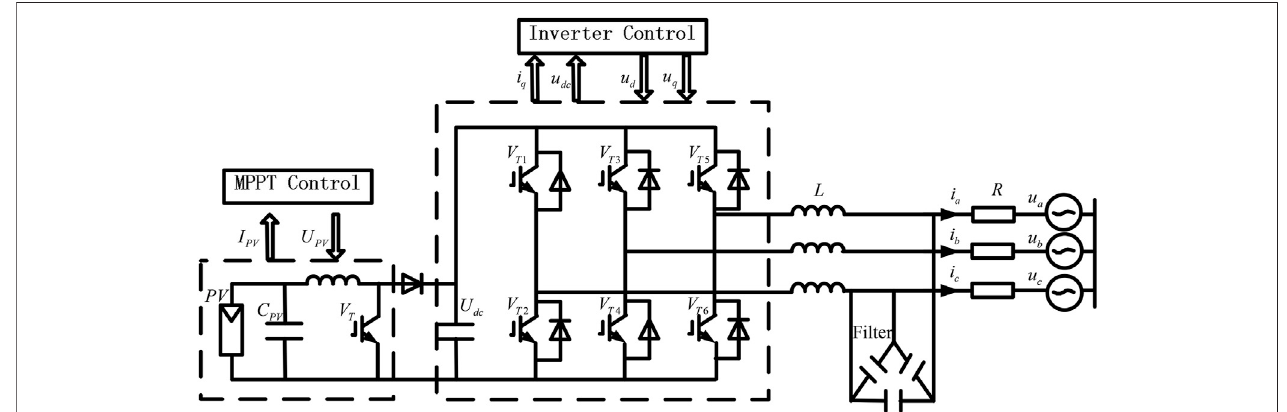
FIGURE 1 | Schematic diagram of the two-stage three-phase photovoltaic system.